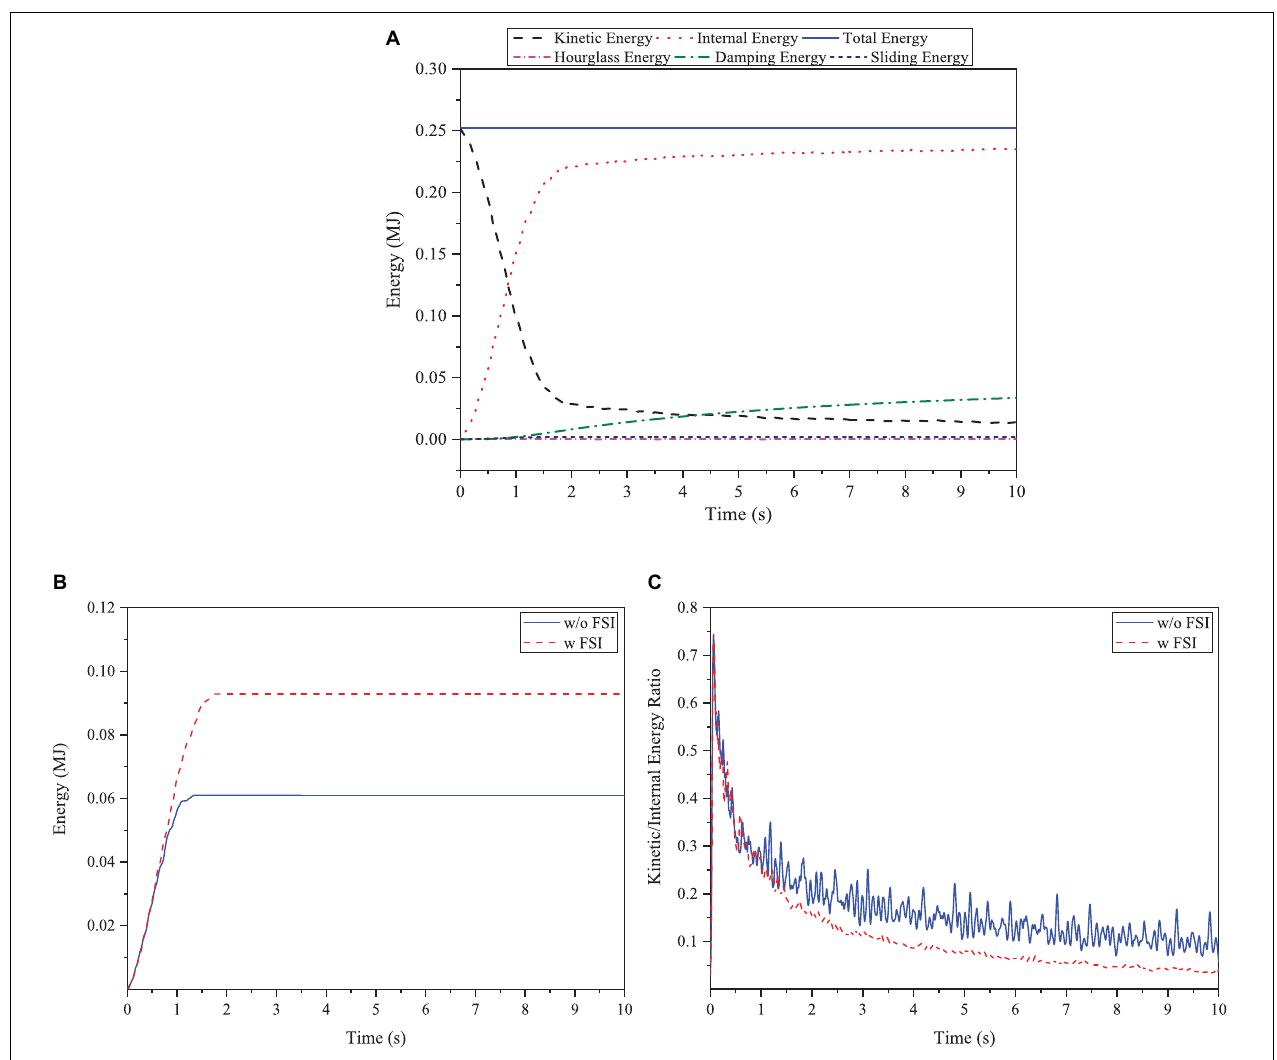
FIGURE 12 | Sea ice and structure energy variation. (A) Energy variation of the collision coupling system; (B) Sea ice erosion energy variation, and (C) Ratio of structure kinetic energy to internal